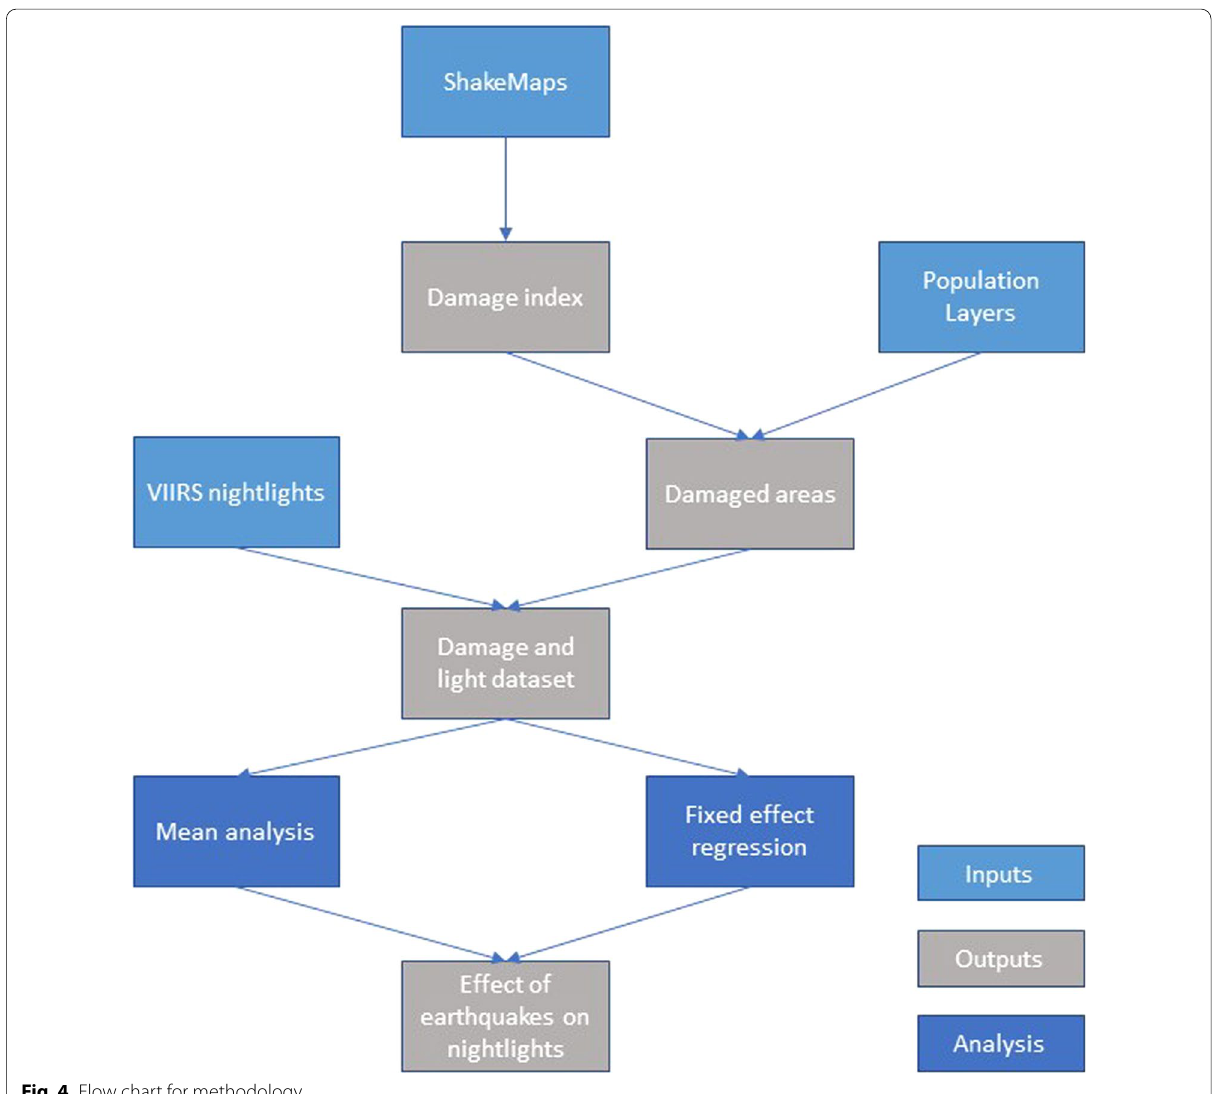
Fig. 4 Flow chart for methodology